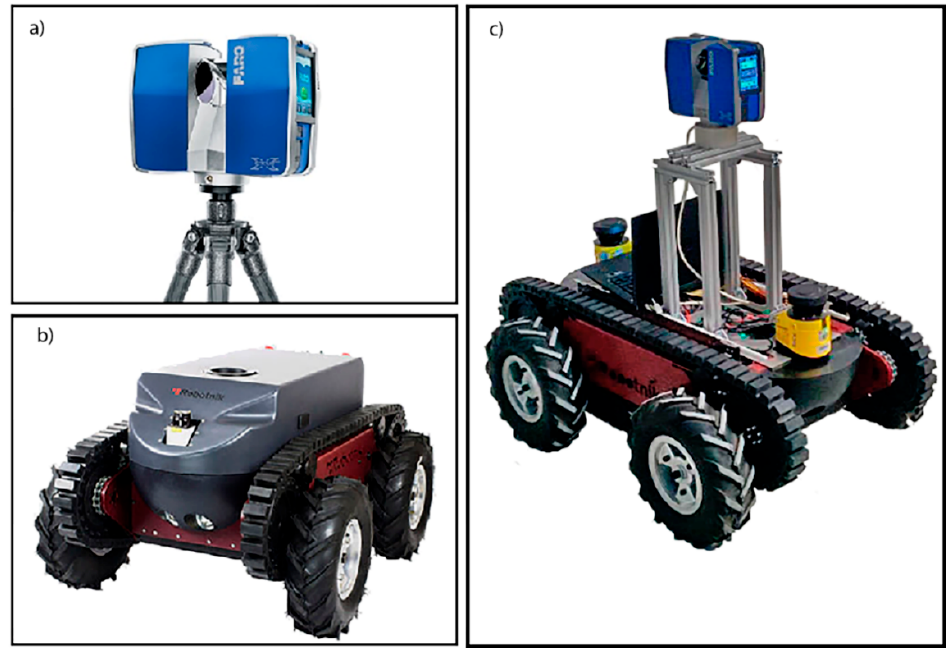
Figure 1. System used for data acquisition: ( a ) terrestrial laser scanner FARO 3D × 330. ( b ) Un- named ground vehicle guardian from Robotnik. ( c ) Hybrid system: terrestrial laser scanner (TLS) on unnamed ground vehicle